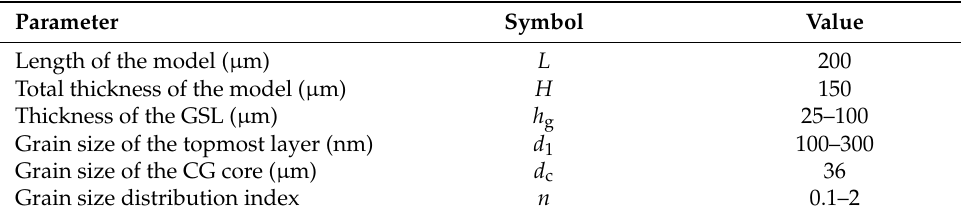
Figure 4. A typical finite element model with 28 homogeneous layers where grain boundaries between layers with different grain sizes are modeled. Table 2. Geometrical parameters of the 2D computational model.